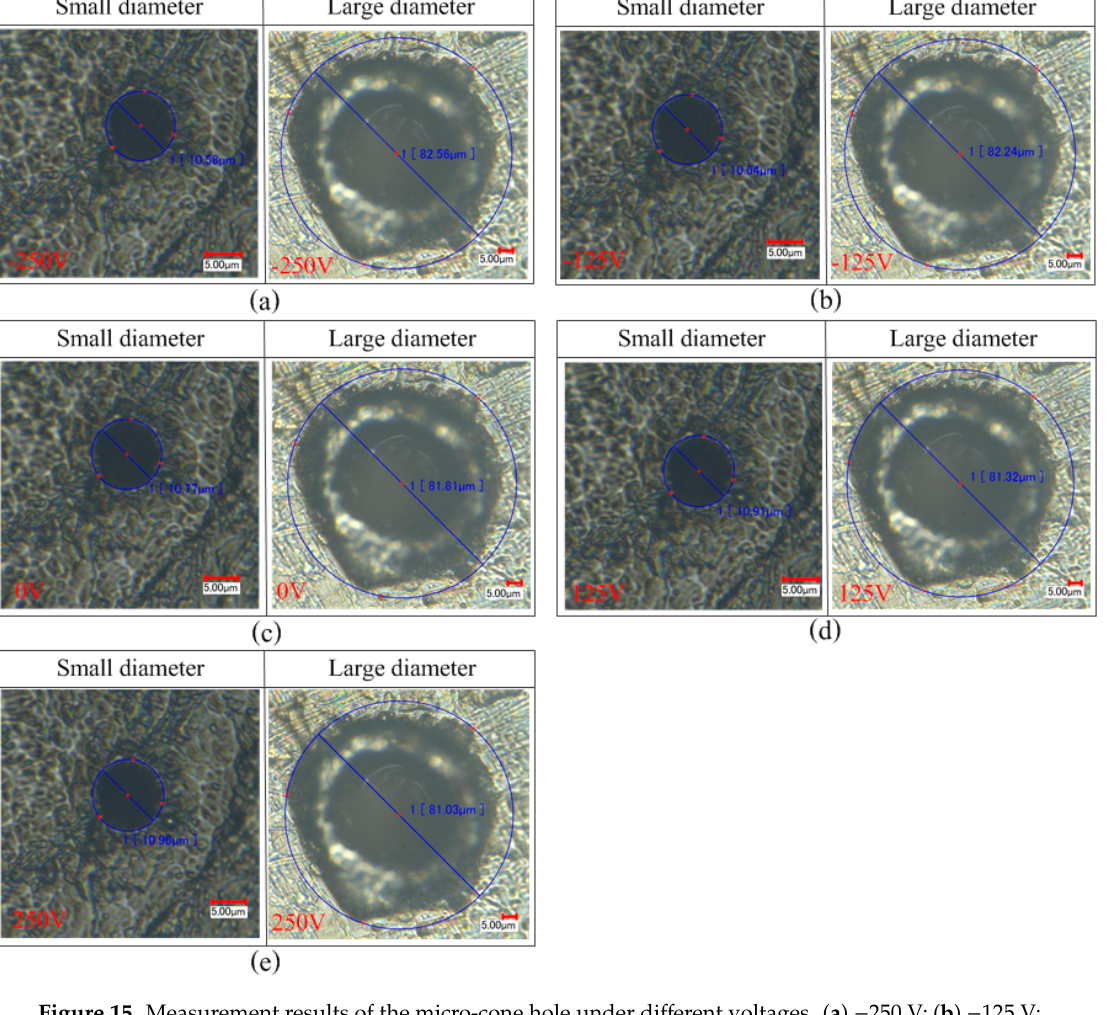
Figure 15. Measurement results of the micro-cone hole under different voltages. ( a ) − 250 V; ( b ) − 125 V; ( c ) 0 V; ( d ) 125 V; ( e ) 250 V.